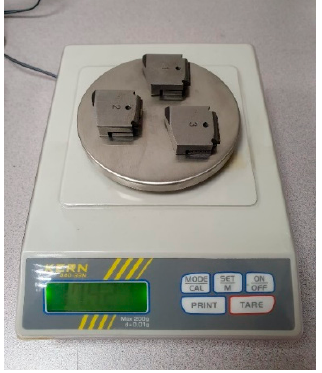
Figure 5. Scale used to weigh the abrasive stones and tool holders .